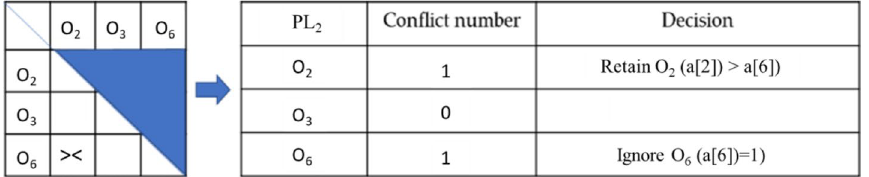
Table 6 Conflict and result of conflict‑solving process